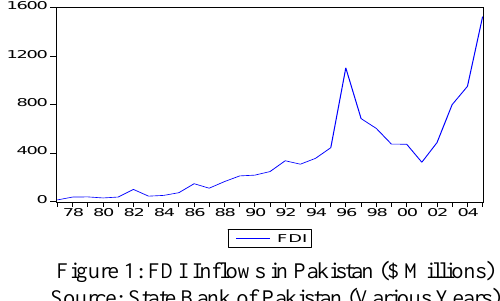
Figure 1: FDI Inflows in Pakistan ($ Millions) Source: State Bank of Pakistan (Various Years)